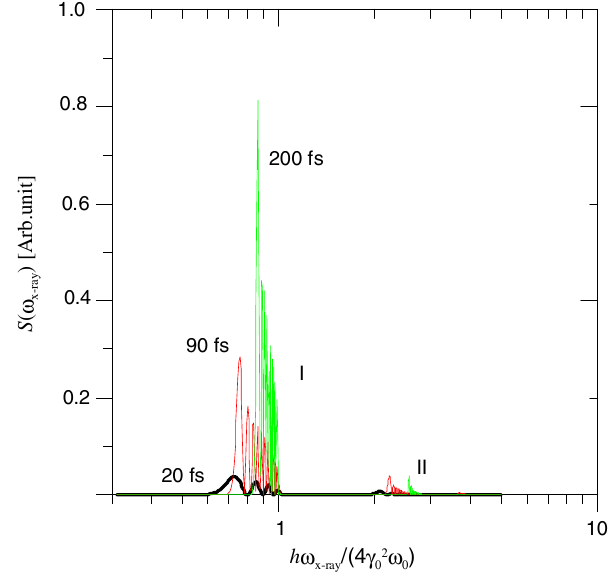
FIG. 1. Spectra of backward scattering ( θ ¼ π ) at a 0 ¼ 1 for Gaussian pulses of duration 20, 90, and 200 fs; head-on collision at γ ¼ 200 . (I) are the fundamental harmonics, and (II) the third harmonics (even harmonics for the linear polarized laser pulse vanish). Radiation damping is